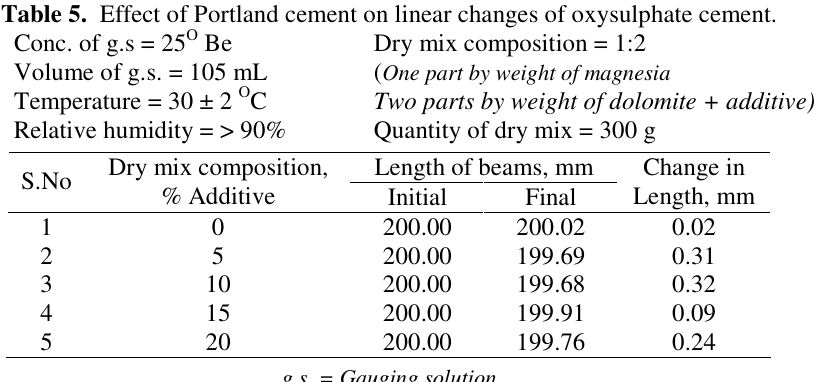
Table 5. Effect of Portland cement on linear changes of oxysulphate